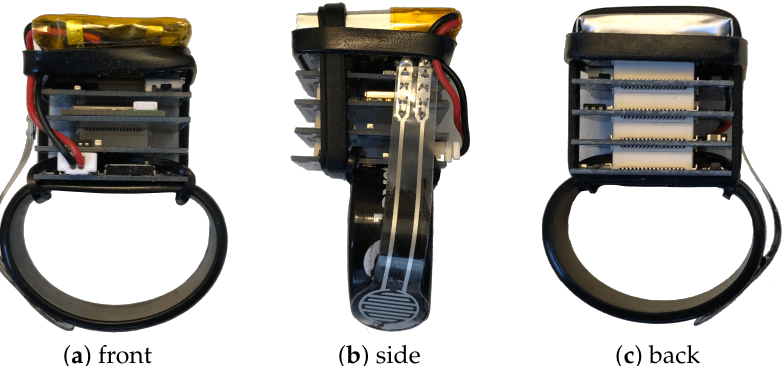
Figure 1. Custom built smart ring with an elastic mounting and a force sensitive resistor on the side of the ring. From bottom to top the modules are the processor board, the sensor module, the Bluetooth module, the USB shield, the prototyping board and the